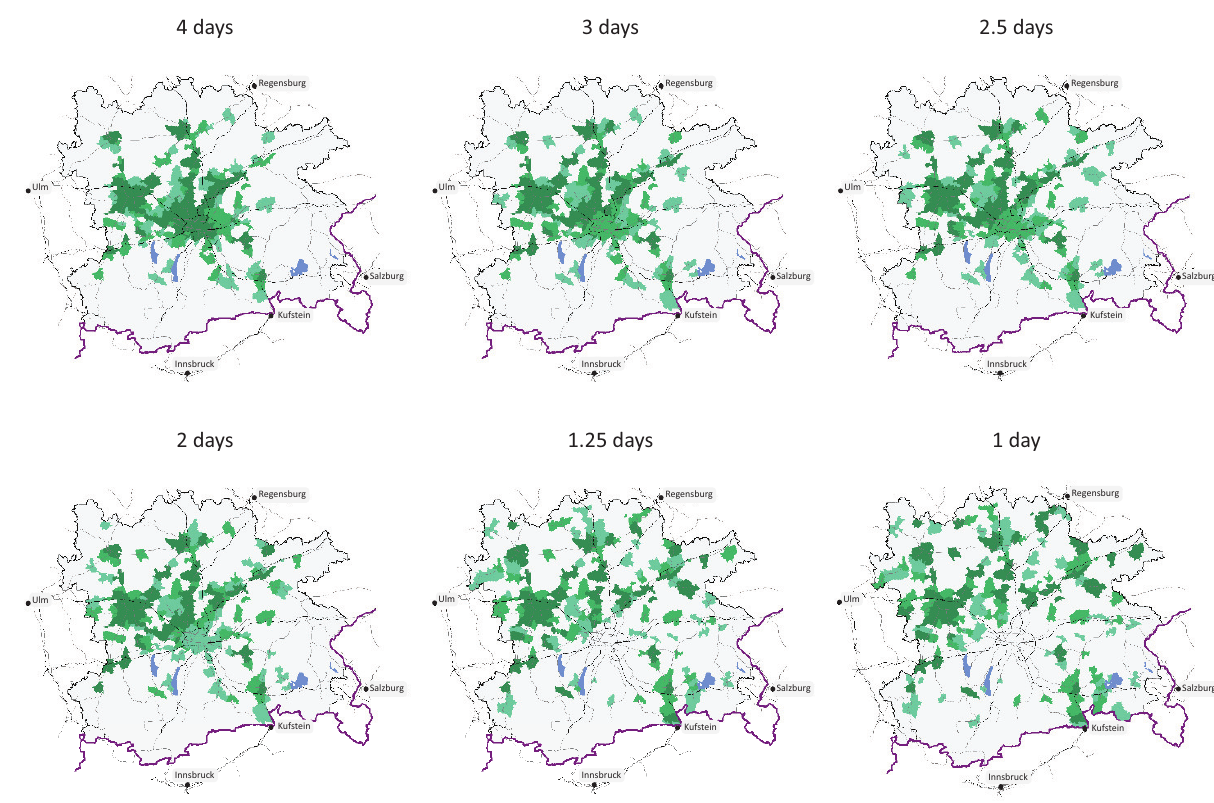
Figure 6. Sensitivity analysis with different 𝛽 values that represent the change from five to fewer commuting days. the map are similar to those that have already been des‐ tinations of suburbanisation in the past. Over the